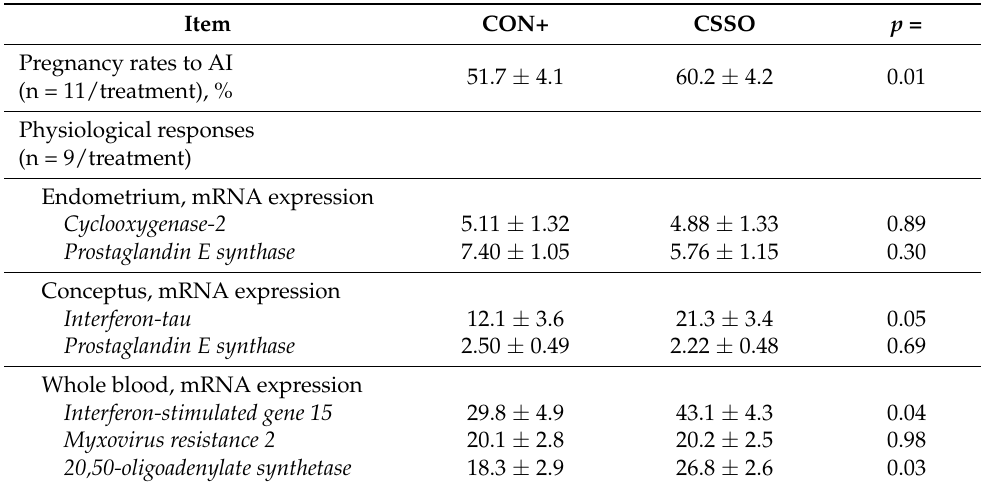
Table 2. Pregnancy rates and expression of mRNA (relative fold change) of genes associated with pregnancy establishment in B. taurus cows receiving Ca soaps of soybean oil (CSSO) or prilled saturated fat (CON+) after artificial insemination. Values reported are least square means ± standard error. Adapted from Brand ã o et al. [26] 1